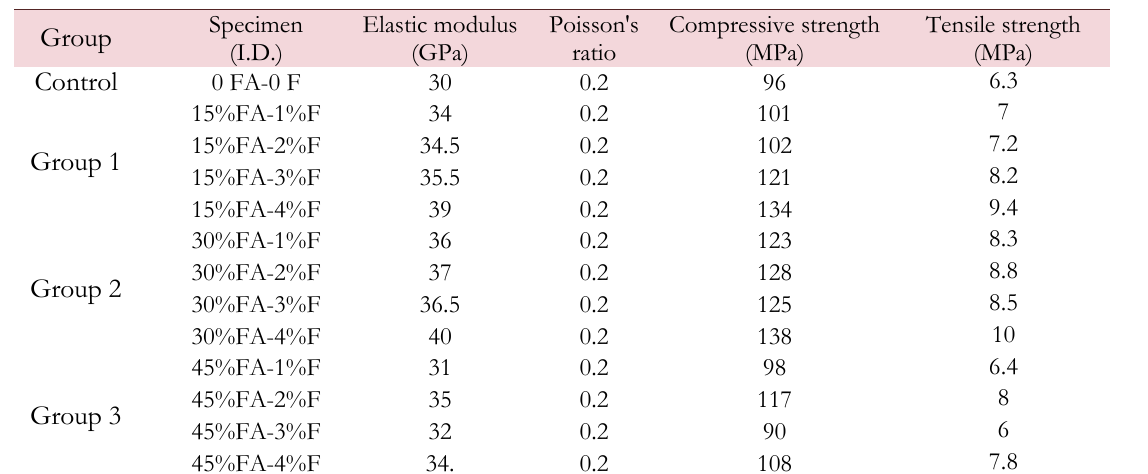
Table 5: The mechanical properties of concrete from experimental work .